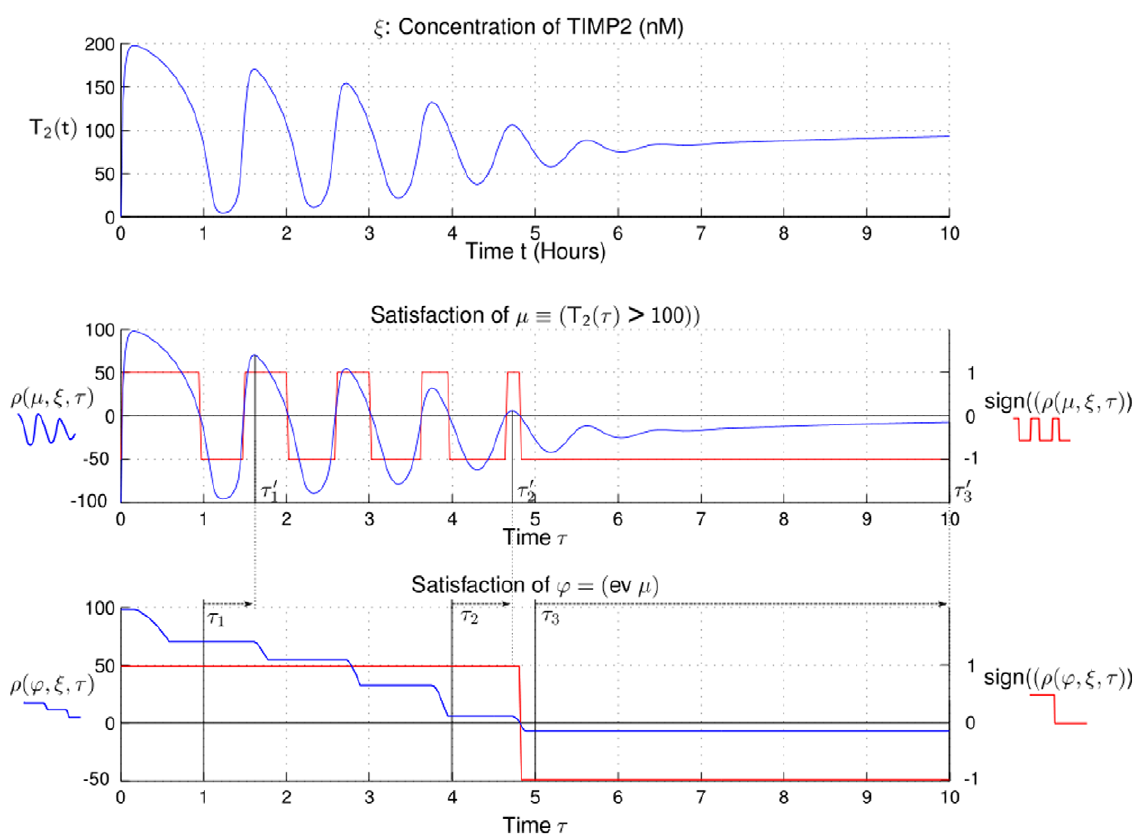
Figure 2. Illustration of a simple formula involving the eventually operator. From the behavior on the upper panel we evaluate the quantitative ( r ) and boolean ( sign ) satisfaction of the predicate m and the formula ev m . Each plateau corresponds to the amplitude of the highest peak in the future. The value of r ( Q , j , t i ) for i ~ 1,2,3 is given by r ( m , j , t i 0 ) which is equal to T 2 ( t i ) { 100 . The formula is satisfied at times t 1 and t 2 but the satisfaction is more robust for t 1 while it is weakly falsified at time t 3